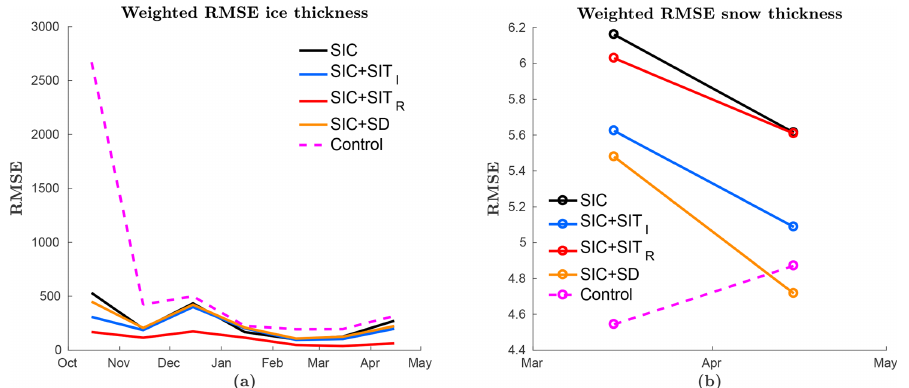
Figure 5. RMSE of monthly averaged model SIT and snow depth averaged over all ensemble members for the years 2011–2013 calcu- lated against the (a) combined SMOS-CryoSat-2 SIT product and (b) observed snow-depth product. These are observations also used for assimilation. The colour coding is as in Fig. 2.